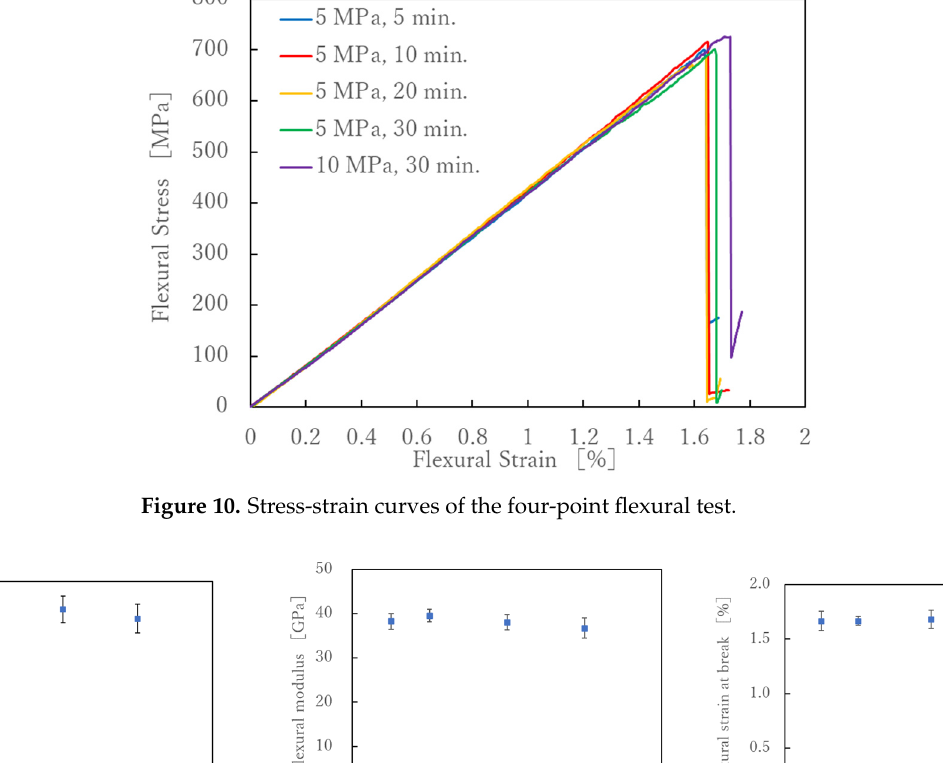
Figure 12. ( a ) Effect of molding pressure on flexural strength under molding time of 30 min; ( b ) Effect of molding pressure on flexural modulus under molding time of 30 min.